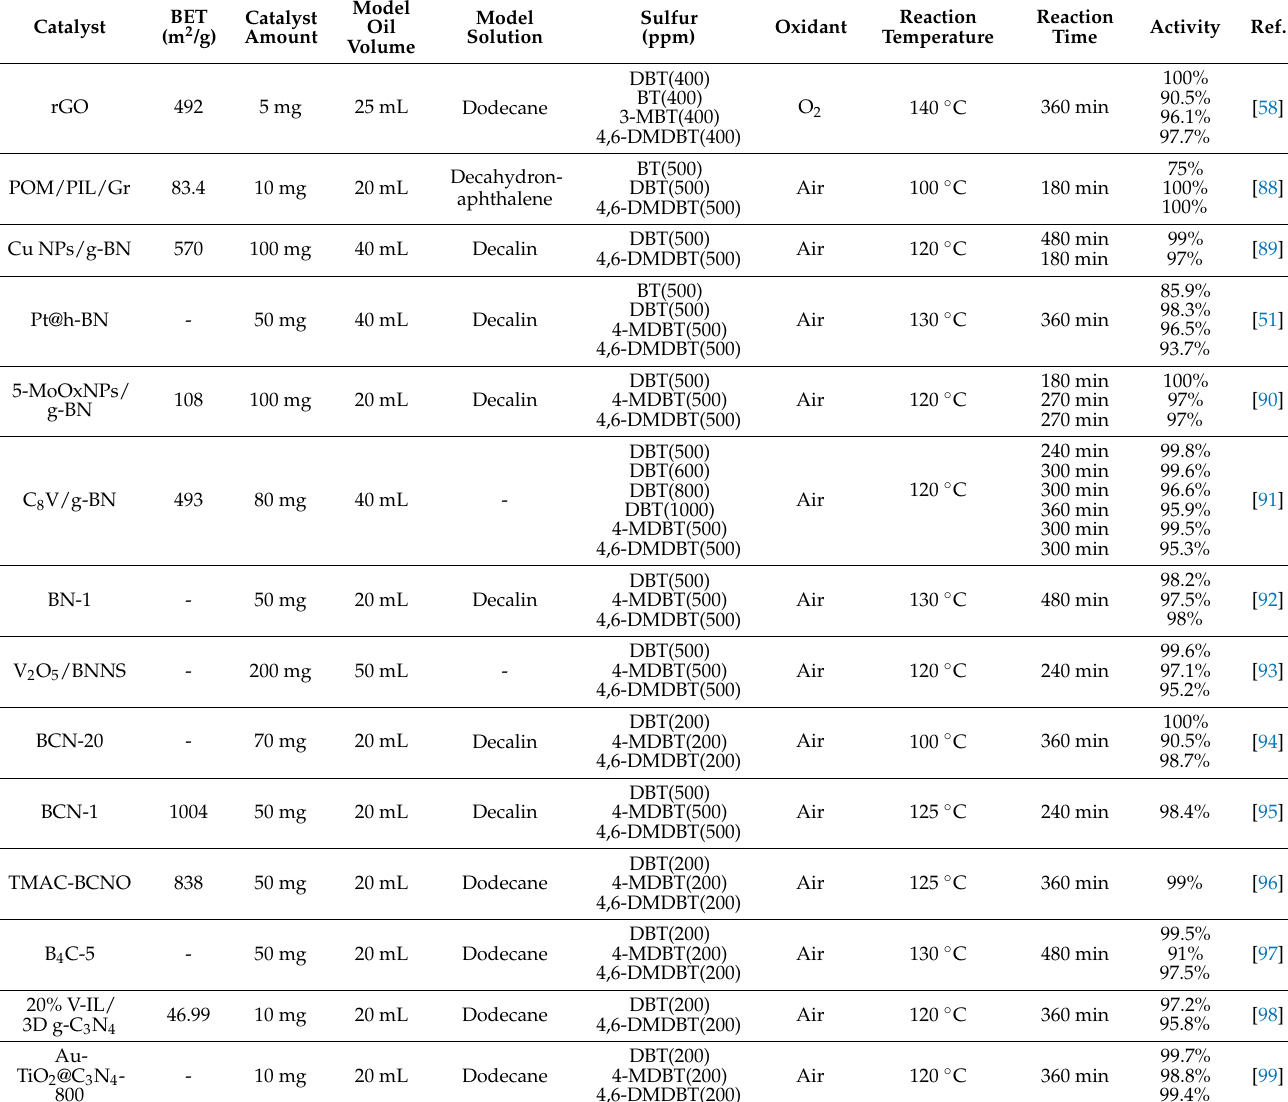
Table 5. Comparison on the catalytic AODS performance for porous graphene and boron-nitride- based